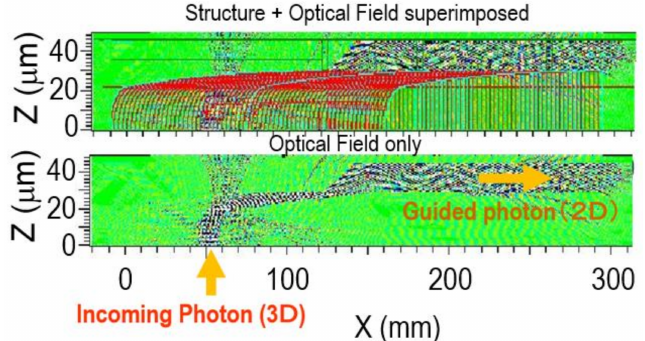
Figure 7. Optical field simulation for the asymmetric waveguide in RWG shown in Figure 6 and in the middle of Figure 2. Many of the incoming photons from the bottom pass through tributary curved waveguides into the 2D slab (main stream) waveguide (top figure). Only the optical field is excerpted (bottom